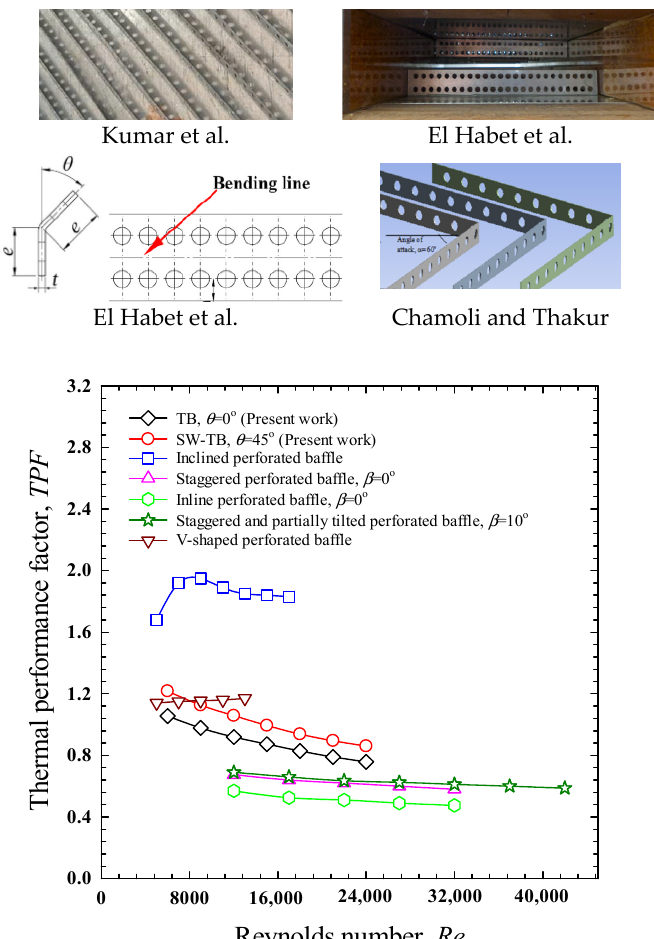
Figure 9. Comparison of the current results and those reported in previously published articles [10,11,17,22].